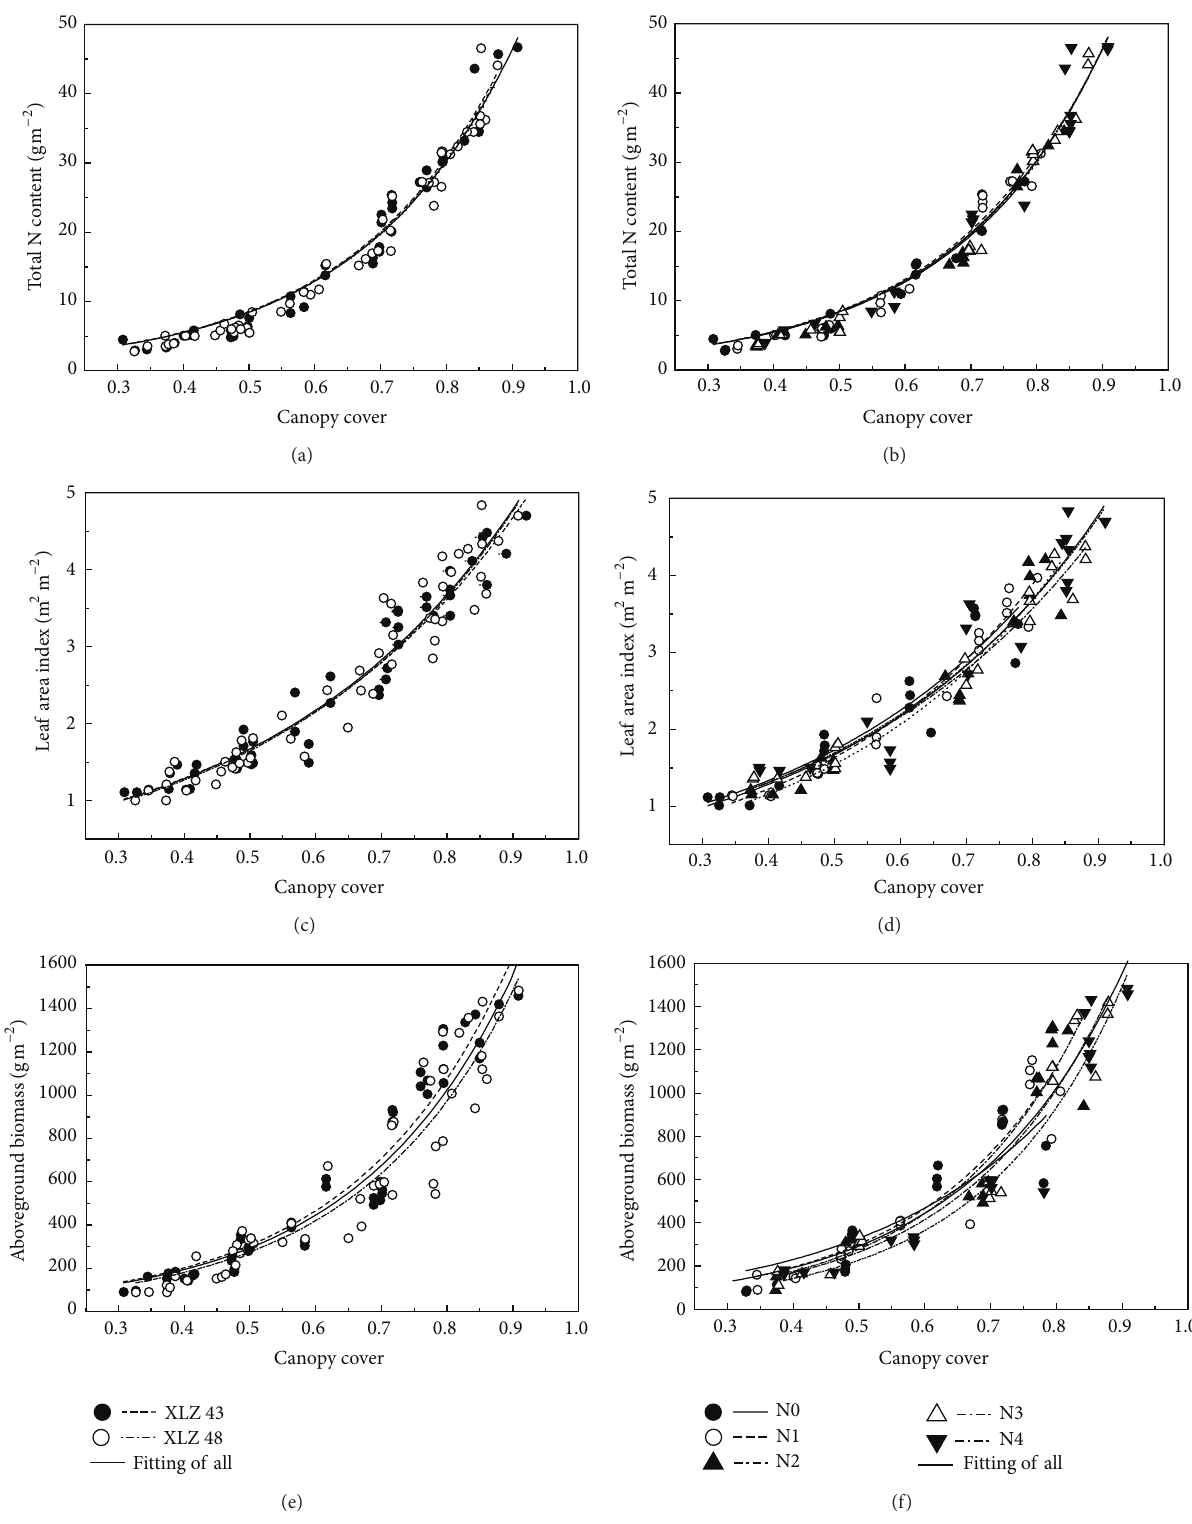
Figure 5: Calibration models describing the relationship between canopy cover and aboveground total N content, LAI, or aboveground biomass in experiment 1. The curves in (a), (c), and (e) were fitted by cotton cultivar: “XLZ 43” or “XLZ 48.” The curves in (b), (d), and (f) were fitted by N rates: 0kg hm −2 (N0), 120kg hm −2 (N1), 240 kghm −2 (N2), 360 kg hm −2 (N3), and 480 kghm −2